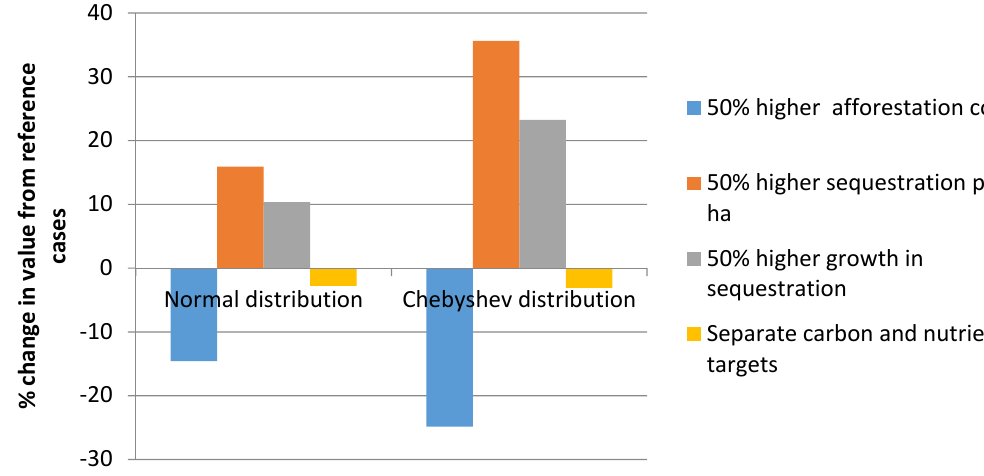
Figure 6. Impacts on the reference value of the forest as an additional pollutant sink under uncertainty with 0.9 probability (289 billion for the normal and 129 billion for Chebyshev the distribution) of different changes in afforestation cost, pollutant sequestration and growth, and separate management of carbon and nutrient